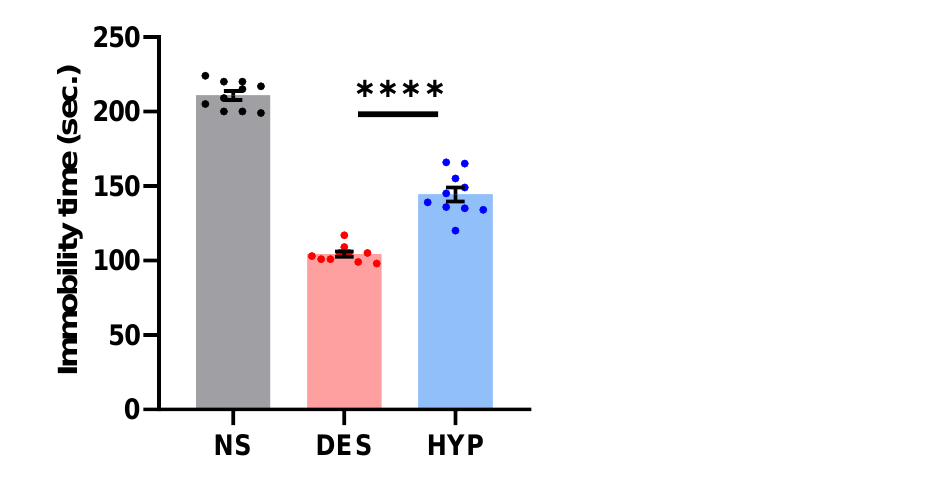
Figure 6. Effect of hypericin (F1) on immobility time in the forced swim test. Statistically significant assessed by an ordinary one-way ANOVA. Graph bars represent means ± SEM. **** p < 0.0001. ( n = 10 for each group). NS: normal saline, DES: desipramine, HYP: hypericin.